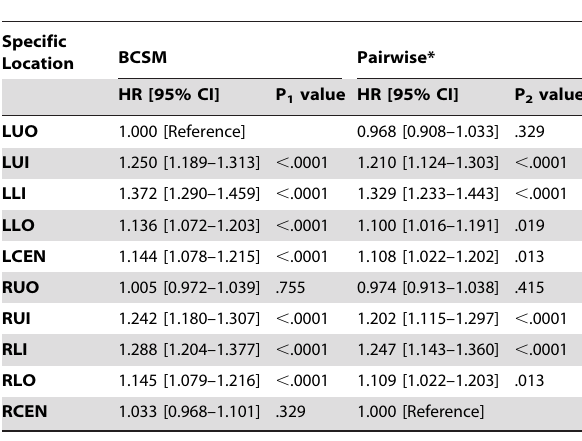
Table 3. Comparison of BCSM Using Combination of Laterality with Primary Tumor